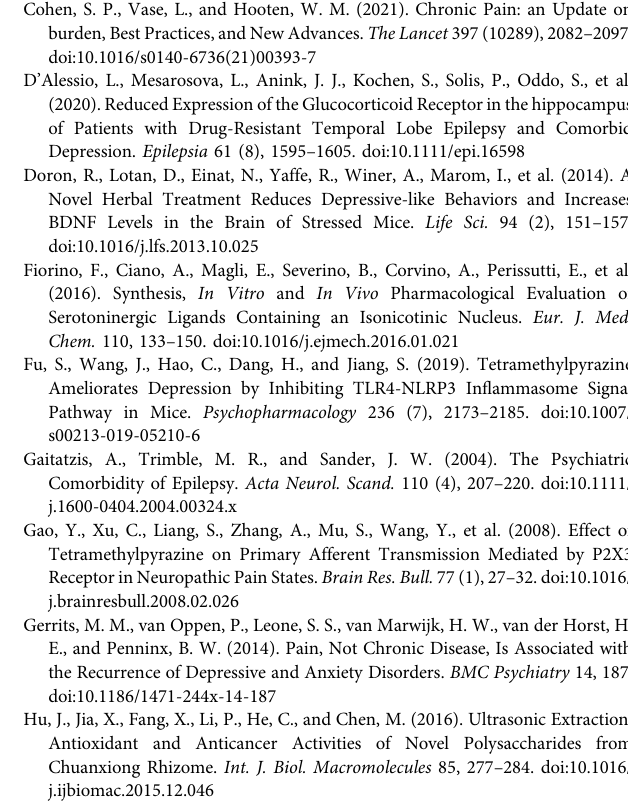
Supplementary Figure S1 | Effects of TMP on close arm entries of EPM both in Kindling and CFA induced pain models. (A) Effects on entries in close arms of EPM testwithTMP(50 mg/kg,i.p.D21 – D35vs.D1 – D35vs.Saline)administrationinafter kindling. (B) Effects on entries in close arms of EPM test with TMP of different TMP administration periods as indicated (25 mg/kg, i.p. D0 – D14, D0 – D28 and D14 – D28 vs. saline). Statistical analysis was performed by one way ANOVA, followed by